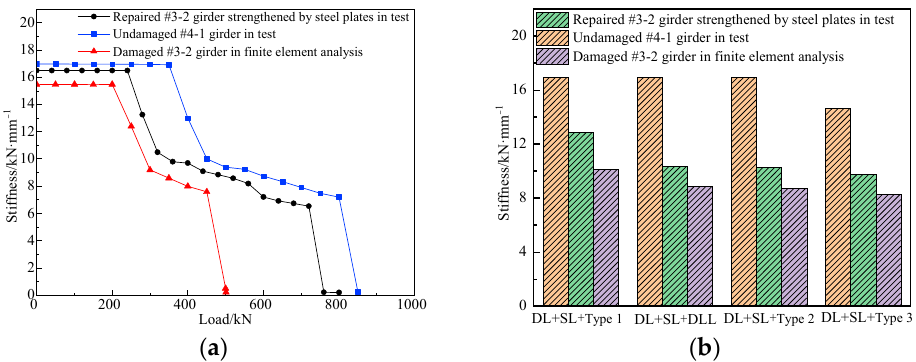
Figure 23. Stiffness comparison. ( a ) Load vs. stiffness curve; ( b ) Stiffness degradation under different live loads.